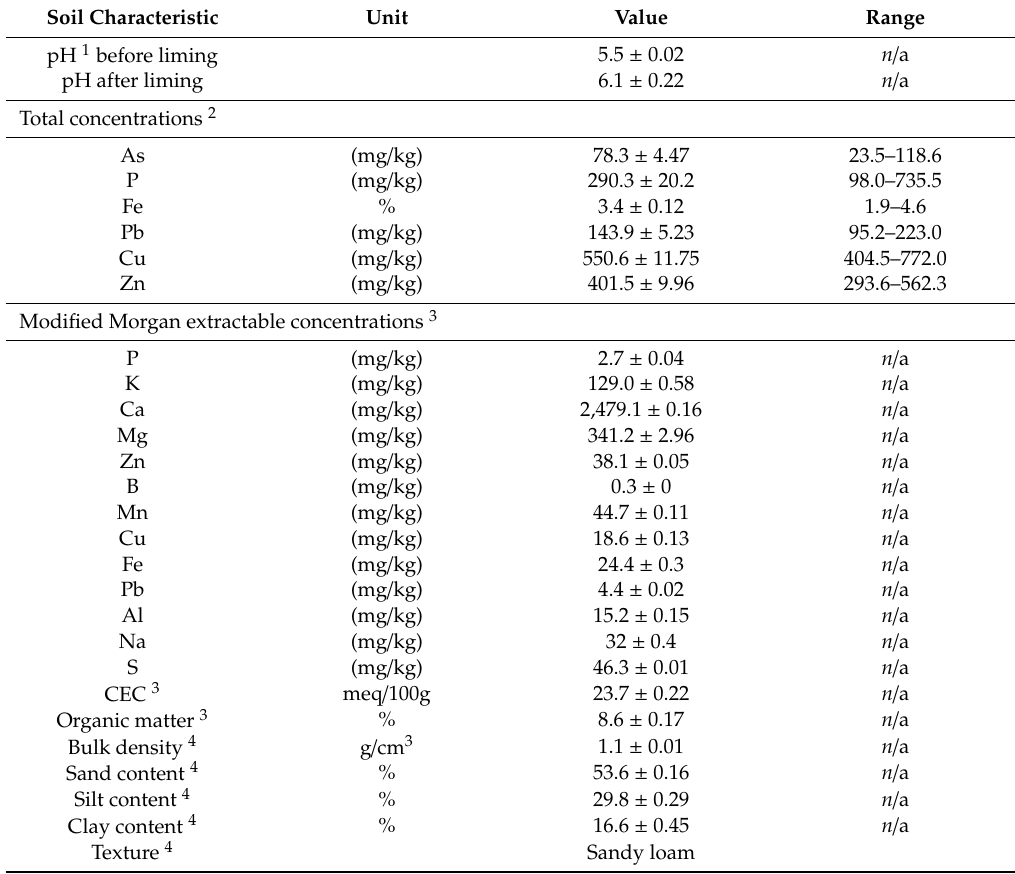
Table 1. Soil characteristics before